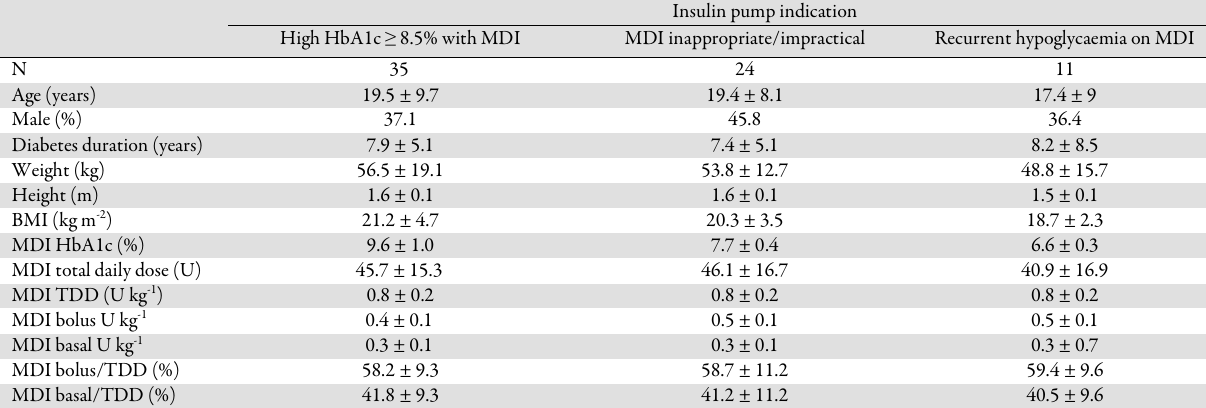
Table 1. Patient baseline characteristics and MDI insulin doses according to insulin pump indication